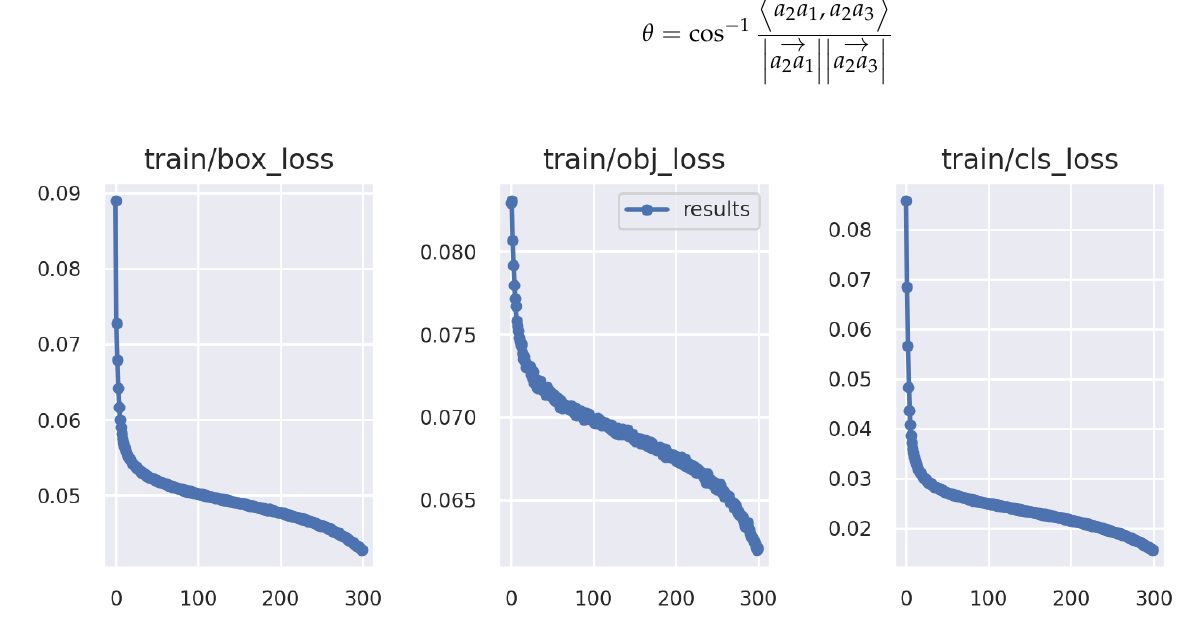
Figure 4. The loss curve of our method.